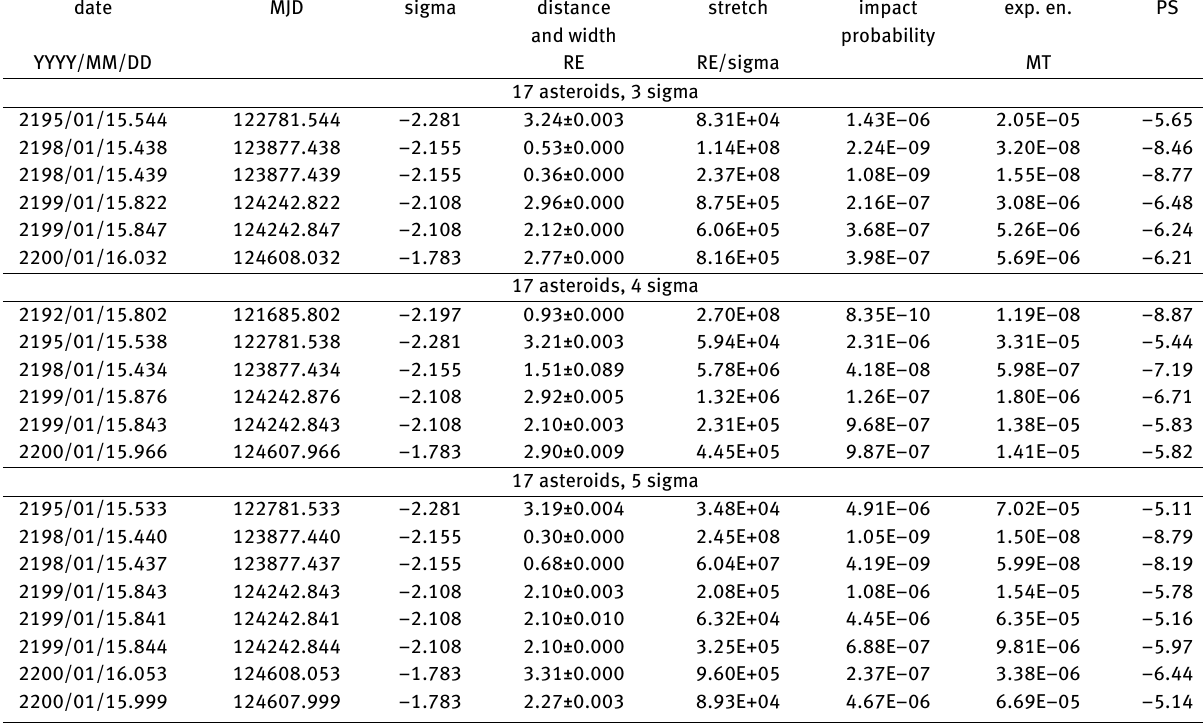
Table 2. The asteroid 2001 BB16. The LOV 1 method. The earliest possible impacts were computed with a different number of perturbing asteroids, different sigma and for computed non-gravitational parameter A 2=(34.551±7.384)·10 −14 au/d 2 . The JPL DE431 Solar System model is